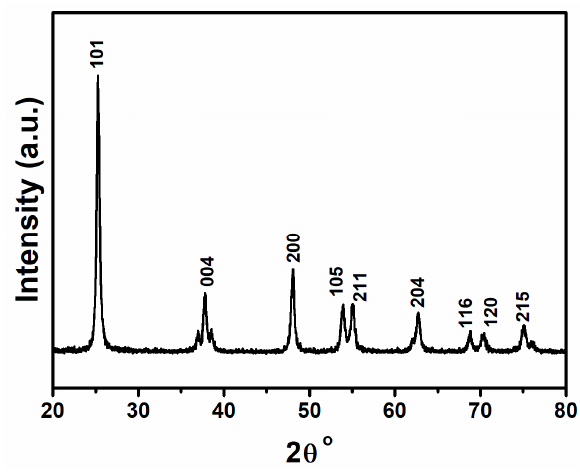
Figure 1. X-ray diffraction (XRD) pattern of TiO 2 nanotube arrays prepared via the anodization